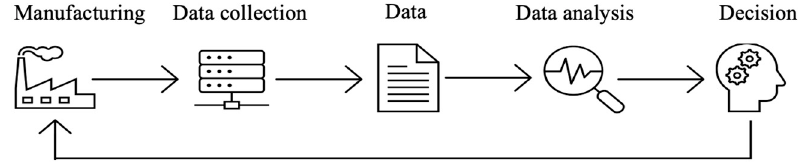
Figure 2. Data collection process (Own processing [17]).